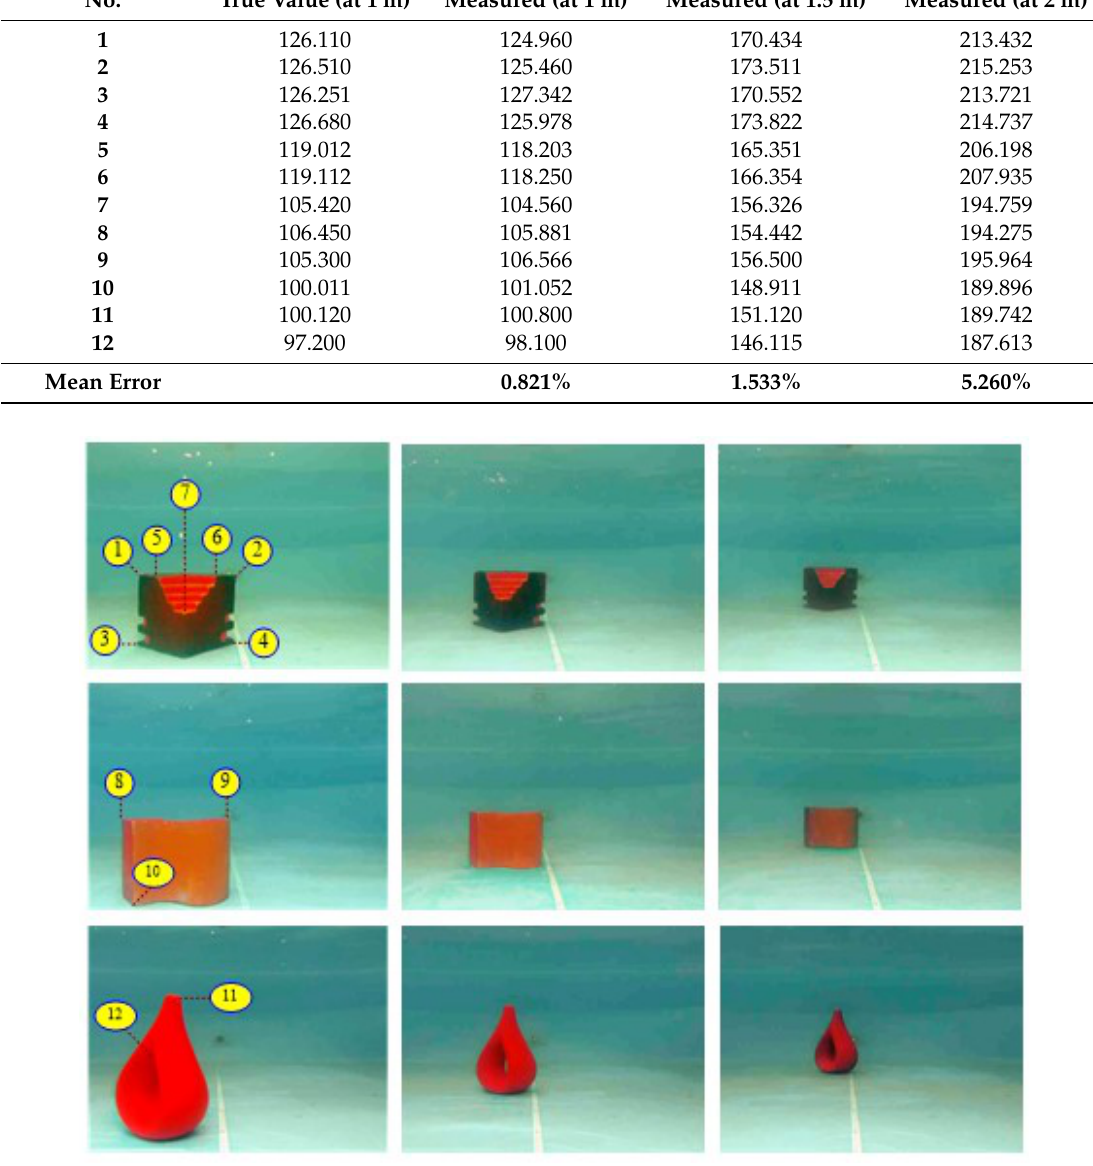
Figure 14. Underwater targets with observed points marked for distance measurement, the distances are about 1 m, 1.5 m and 2 m from left to right.